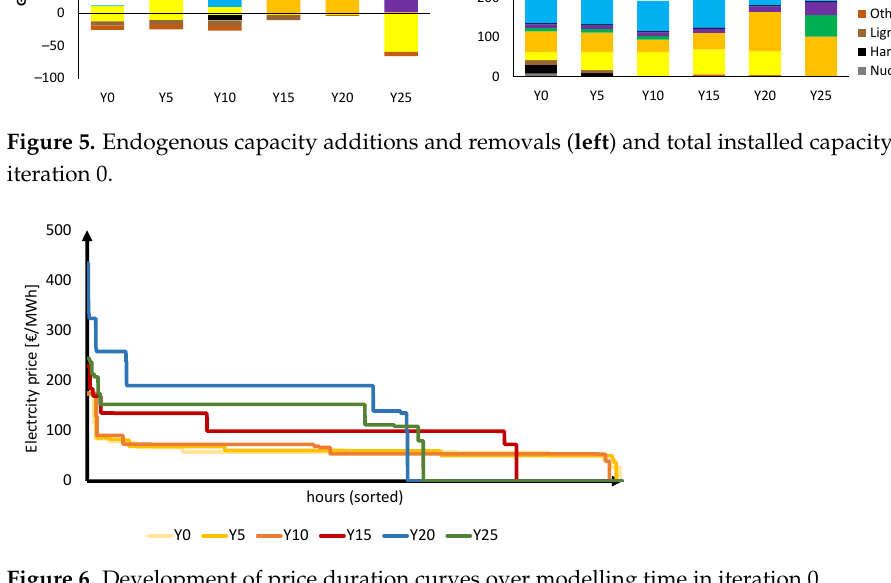
Figure 7. Uncovered fixed costs for invested technologies in iteration 0. Wind onshore and PV show a relatively small rent deficit within the years Y0-Y20. This is because VRE is hardly generated at all in the hours of greatest scarcity, which usu- ally occurs during periods of low generation from wind and solar. In turn, this means that scarcity rents have a very small share in covering their fixed costs and, accordingly, the deficit without scarcity prices changes comparatively little. However, the situation is dif- ferent again in Y25, where scarcity prices occur for significantly more hours than in pre- vious years. Accordingly, VRE would then also miss a larger part of their rent. There is a tendency for uncovered costs to increase over time, which is partly caused by the fact that there is a greater scarcity in the system in later years. Although endoge- nous decommissioning is generally allowed in the model, this is not the case for capacities